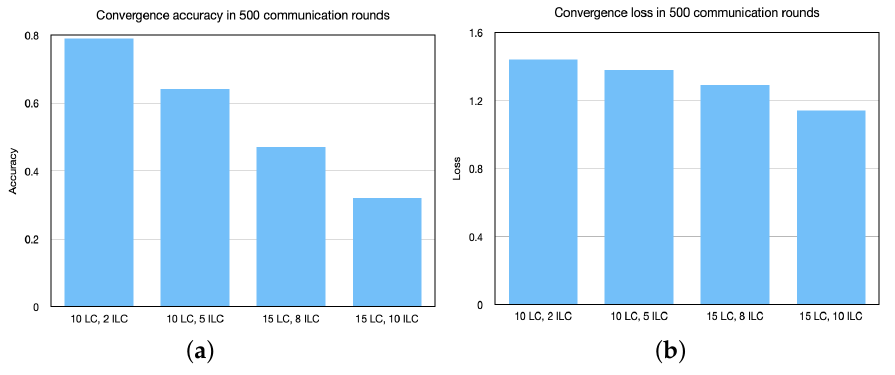
Figure 5. Comparison of SHFL training accuracy and training loss for different numbers of LCs and ILCs on the CIFAR-10 dataset, ( a ) training accuracy over CIFAR-10; ( b ) training loss over